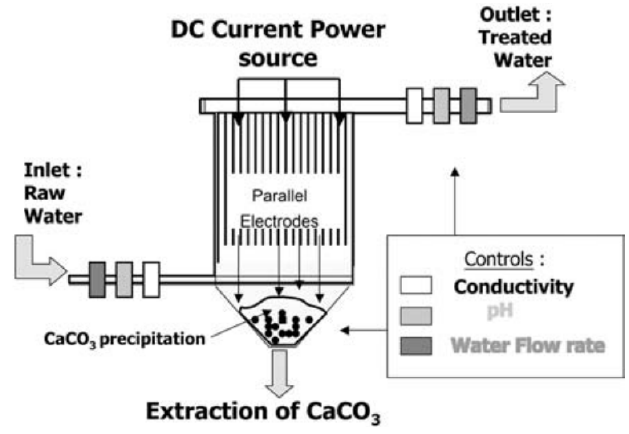
Figure 7. Scheme of the ERCA 2 electrolyser [42].